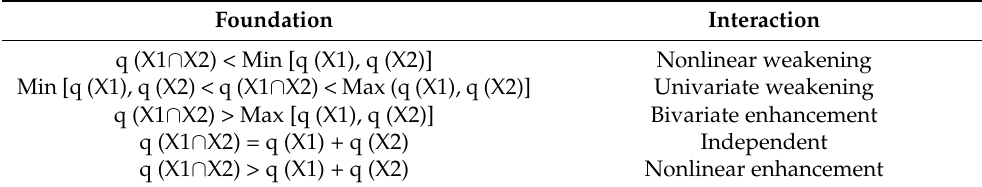
Table 2. Types of